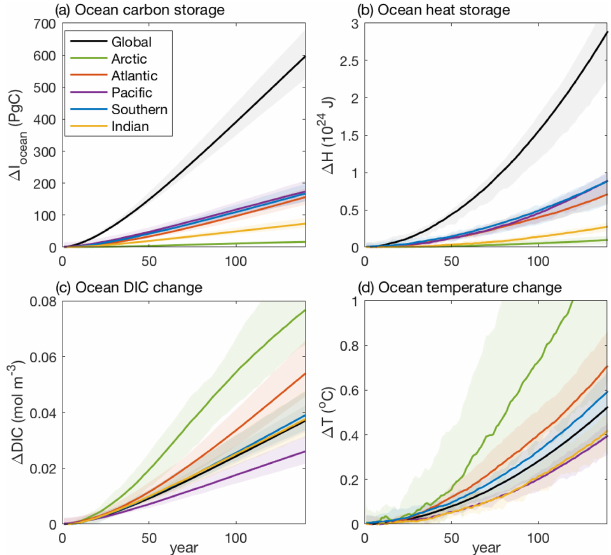
Figure 1. Carbon and heat storage for the global ocean and differ- ent ocean basins in CMIP6 Earth system models: (a) ocean carbon content changes relative to the pre-industrial in petagrams of car- bon; (b) ocean heat content changes relative to the pre-industrial in joules; (c) changes in the ocean dissolved inorganic carbon relative to the pre-industrial in moles per cubic metre, expressing the ocean carbon storage changes per volume; and (d) changes in ocean tem- perature relative to the pre-industrial in degrees Celsius, expressing the ocean heat changes per volume. The solid lines show the model mean and the shading the model range based on the 1%yr − 1 in- creasing CO 2 experiment over 140 years in 11 CMIP6 models (Ta- ble 1). For the definition of the ocean basins see Supplement Fig.